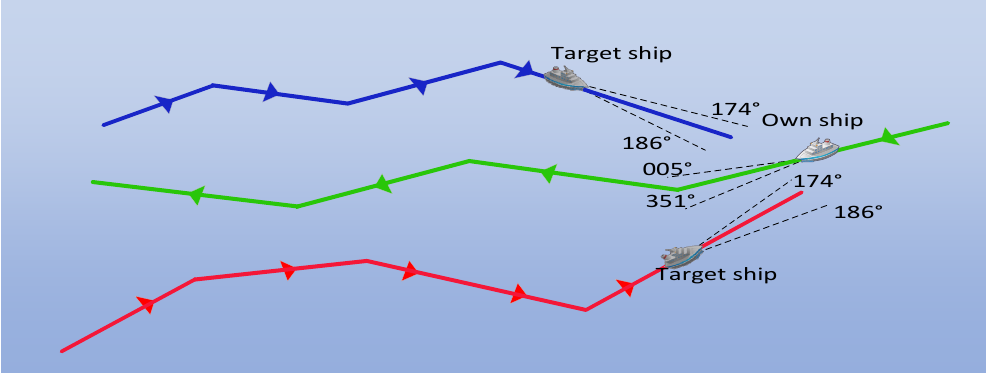
Figure 9. Head-on situation of two-sides clipping scenario schematic diagram.